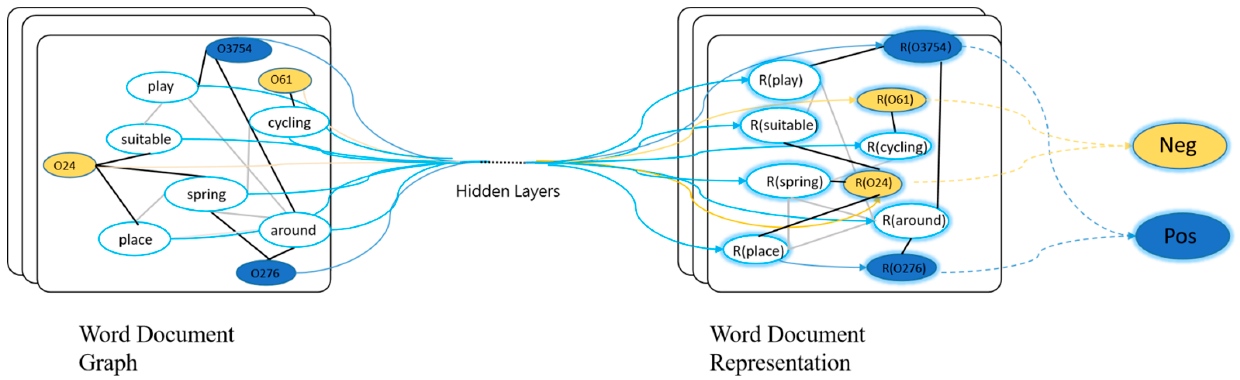
Figure 4. Schematic of